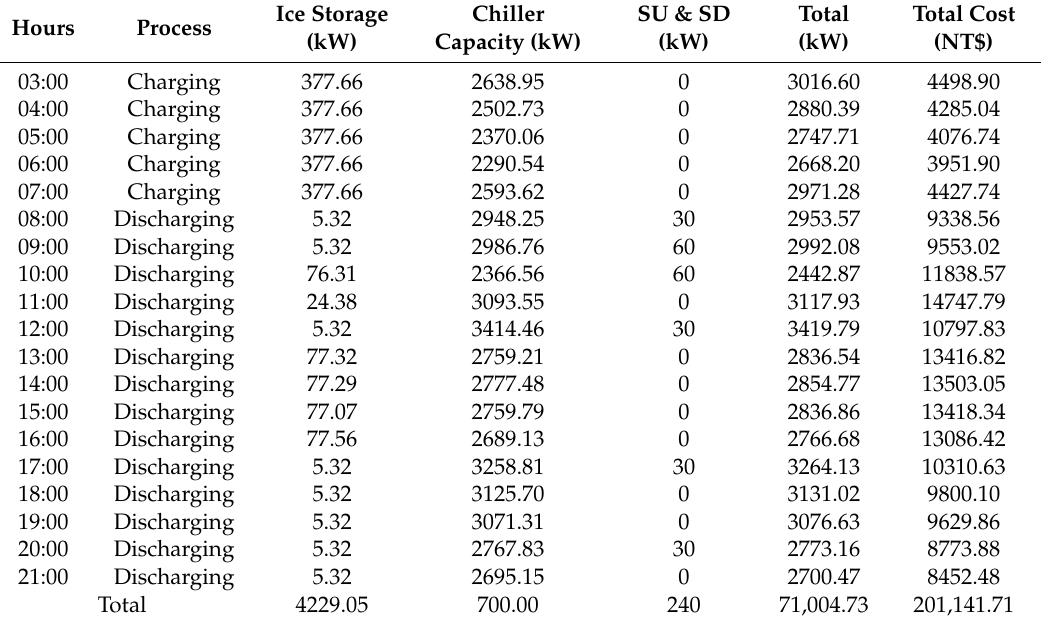
Figure 8. Operating types of ice storage tank in summer.